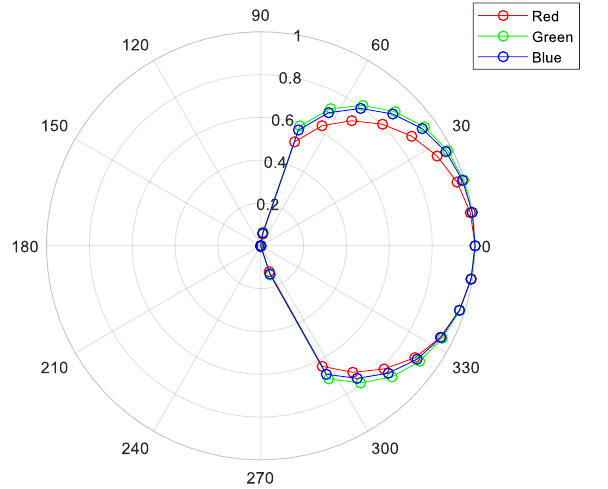
Figure 3. The attenuation curve of the luminance of the three primary colors of the display module.